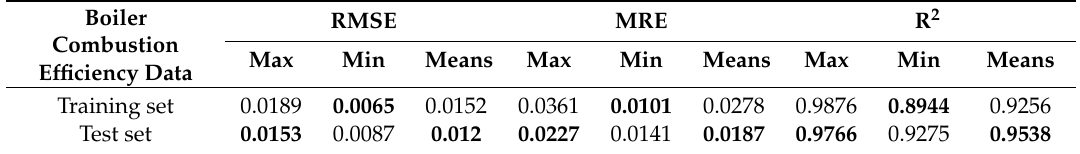
Table 3. Evaluation index of boiler combustion efficiency model based on IDELM